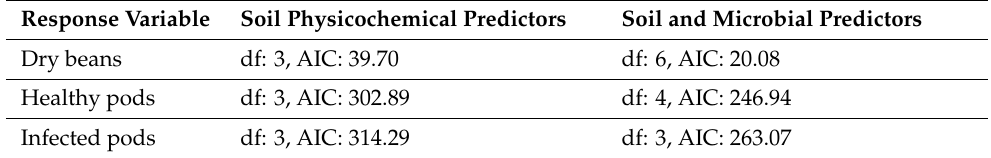
Figure 6. Heatmaps showing variable importance in stepwise regression models for cacao yield metrics using ( a ) only soil physicochemical properties as predictor variables and ( b ) both microbial and soil physicochemical parameters as predictor variables. Brighter colors indicate more important variables in the final model after 10-fold cross-validation, with colors mapped to variable importance on a scale of 0–100 (see histogram in upper left). CEC: cation exchange capacity; PC1: first eigenvector of community composition; PC2: second eigenvector of community composition; B: bacteria; F: fungi. Table 2. Model parameters for stepwise regression analysis. Stepwise regression showed that models using both microbial and soil physicochemical predictor variables had lower AIC values, indicating a better fit, than models with only soil physicochemical